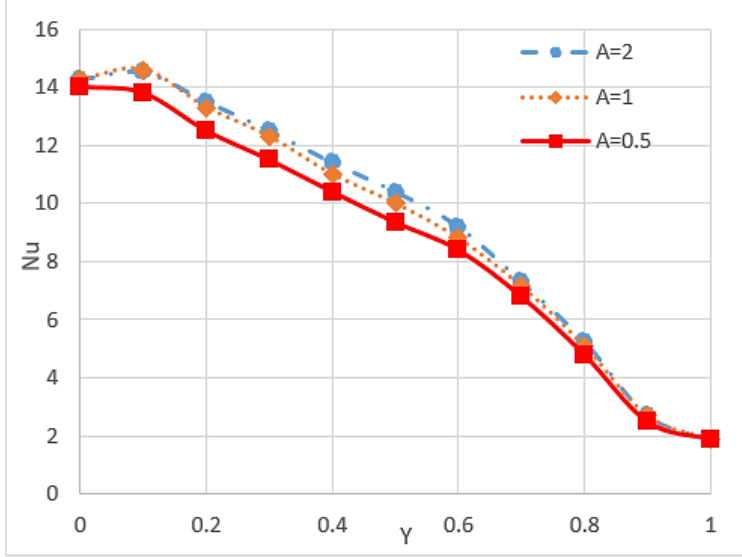
Figure 7. Values of Nusselt number on hot wall ( Y ) at different aspect ratios ( A ) and Ra = 10 5 . [86]